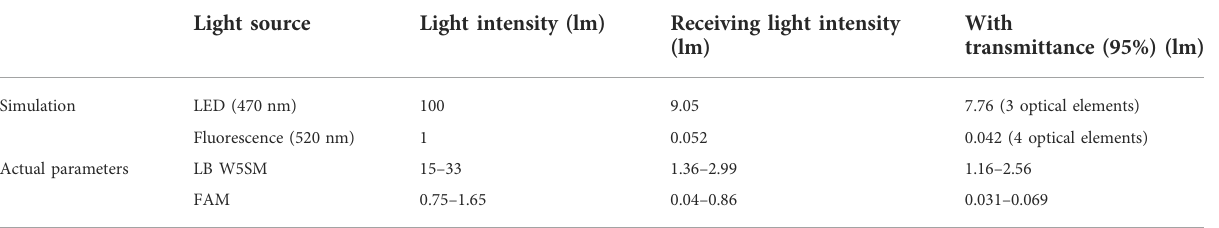
TABLE 2 Results of the fi rst channel simulation